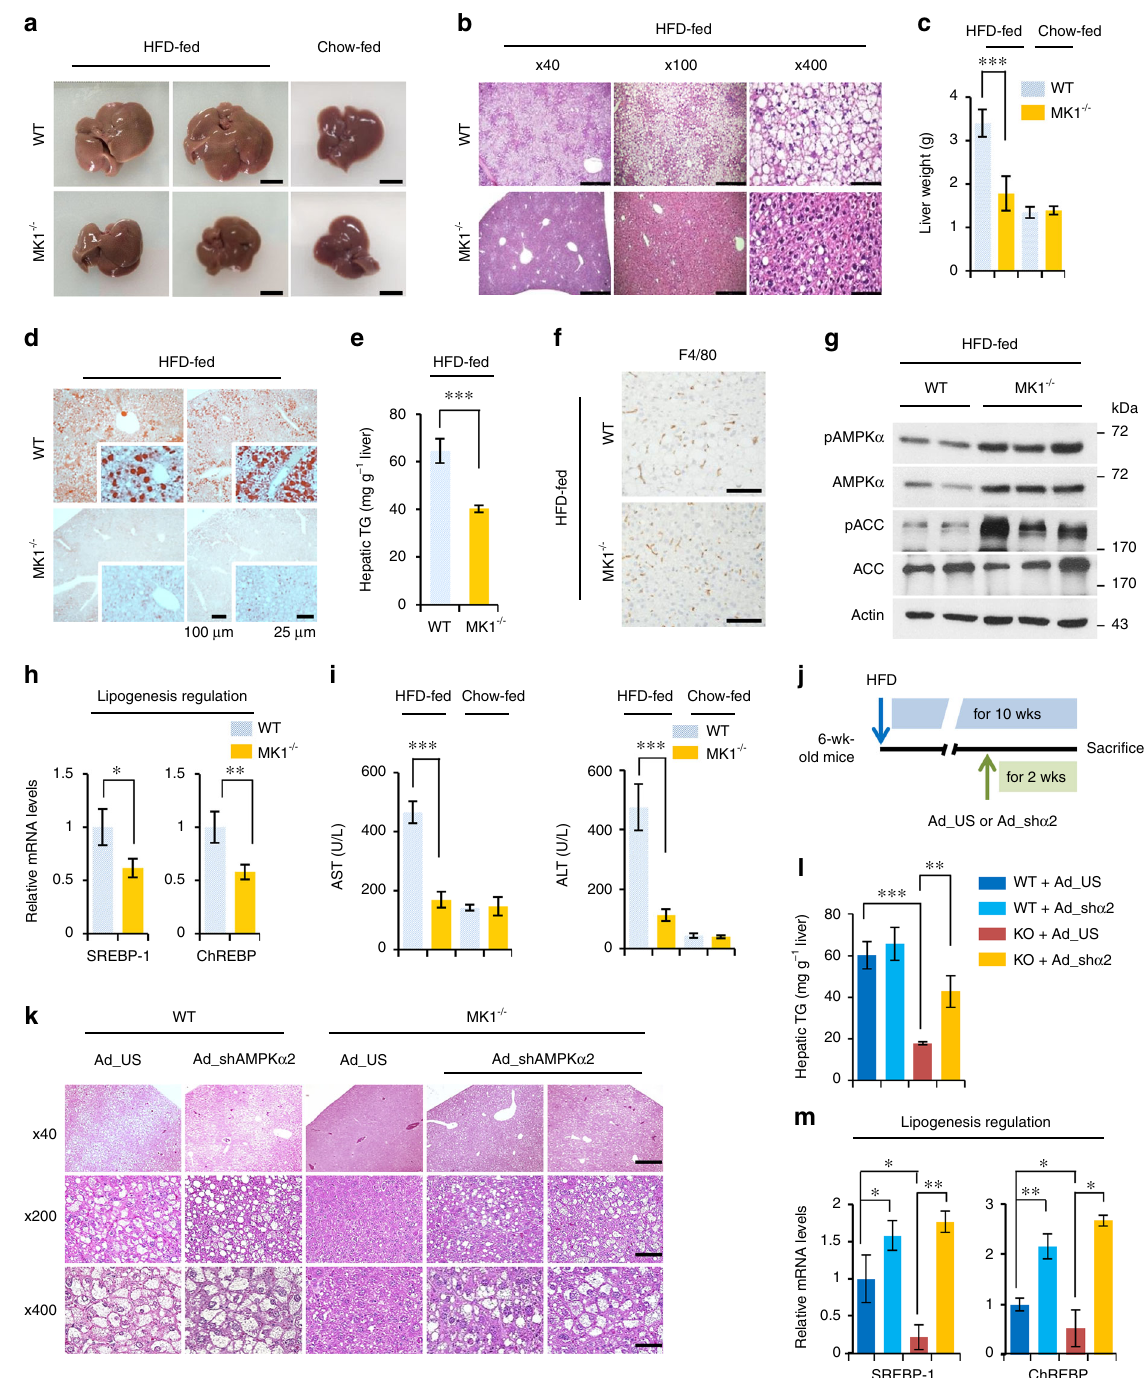
Fig. 4 Effect of MKRN1 de fi ciency on hepatic AMPK signalling and diet-induced NAFLD. Livers from male WT and MK1 − / − mice fed a chow diet or an HFD for 16 weeks were analysed. a Representative livers from mice on an HFD (upper left; fatty livers of HFD-fed WT mice) or a chow diet (upper right; normal livers of chow-fed WT mice). Scale bar = 1 cm. b H&E staining of livers. Scale bar = left, 250 µ m; middle, 100 µ m; and right, 25 µ m. c Liver weights ( n =